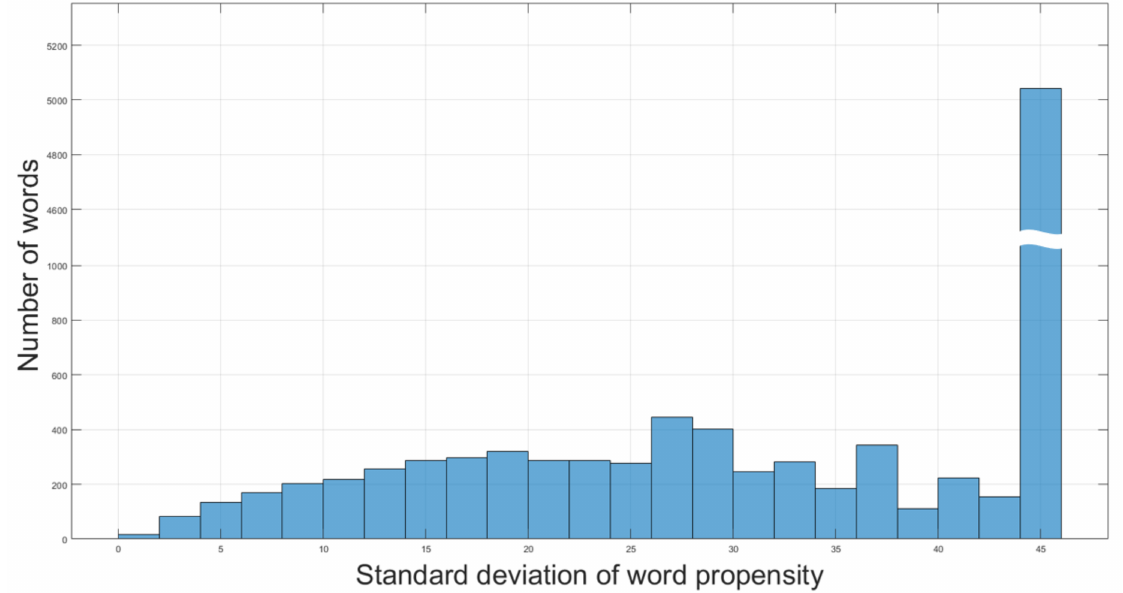
Figure 5. Distribution of the standard deviation for each word propensity